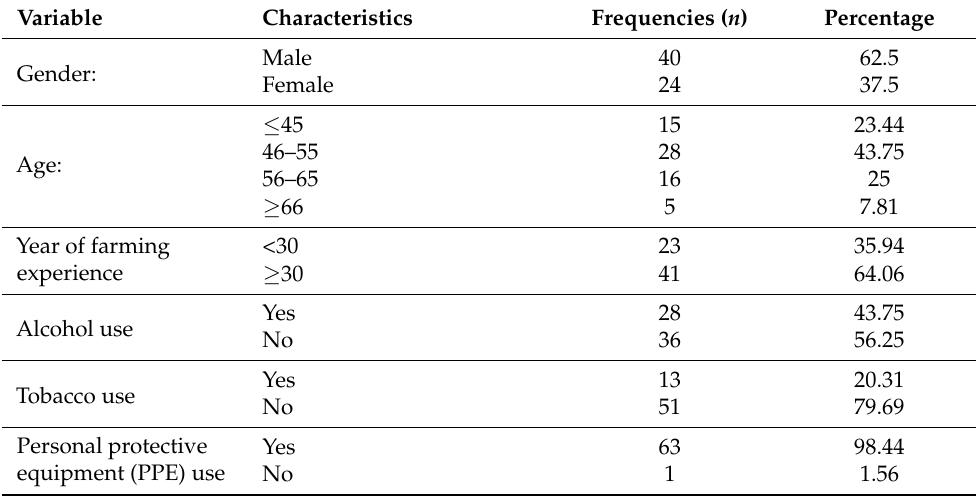
Table 2. The demographic characteristics of studied population ( n =